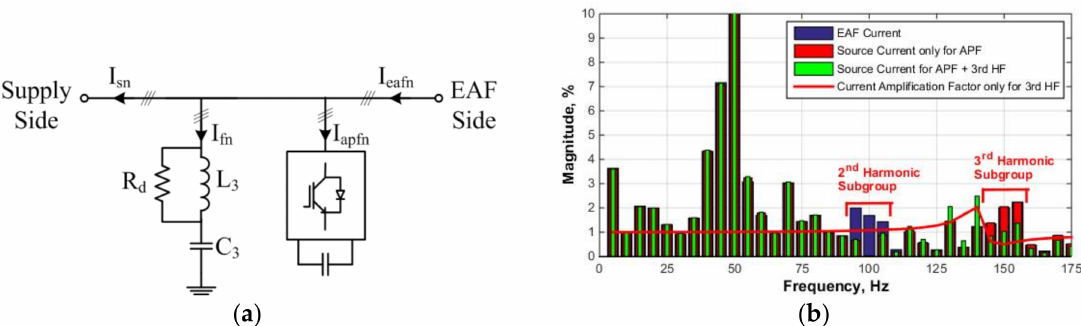
Figure 15. Proposed hybrid filter topology for the suppression of second and third harmonic subgroups, ( a ) block diagram including APF and third HF and ( b ) filtering performance of the proposed topology in comparison with APF only and third HF only solutions (EAF current collected in the field and single phase currents are expanded in DFT with 5 Hz